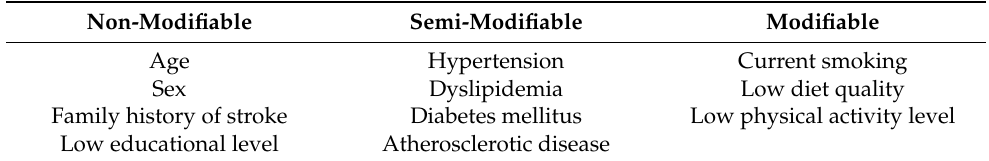
Table 2. Summary of main findings. The table shows the independent non-modifiable, semi-modifiable, and modifiable risk factors for atherothrombotic ischemic stroke identified in this population-based